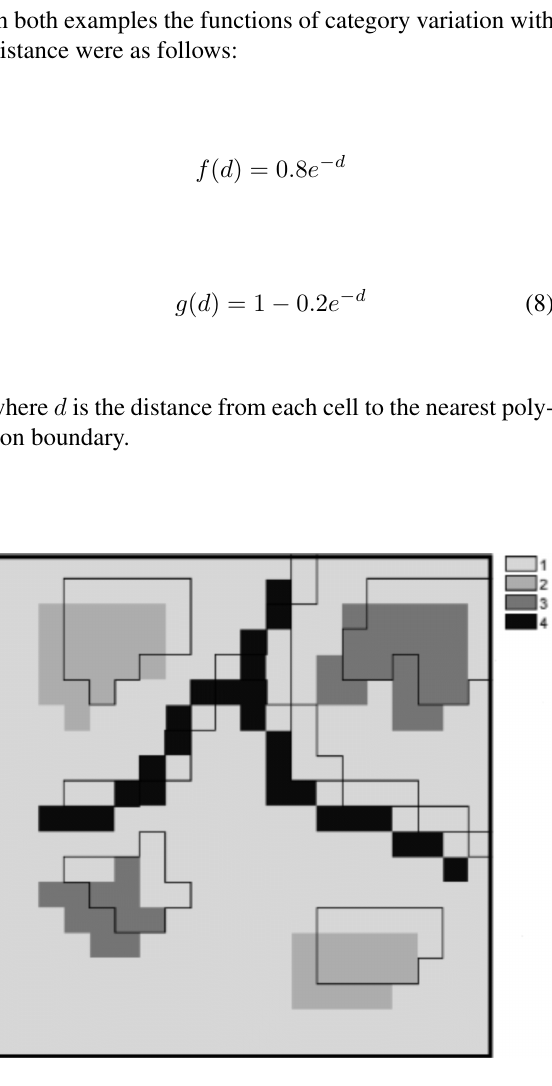
Fig. 2: Vector synthetic map B overlaying raster synthetic map